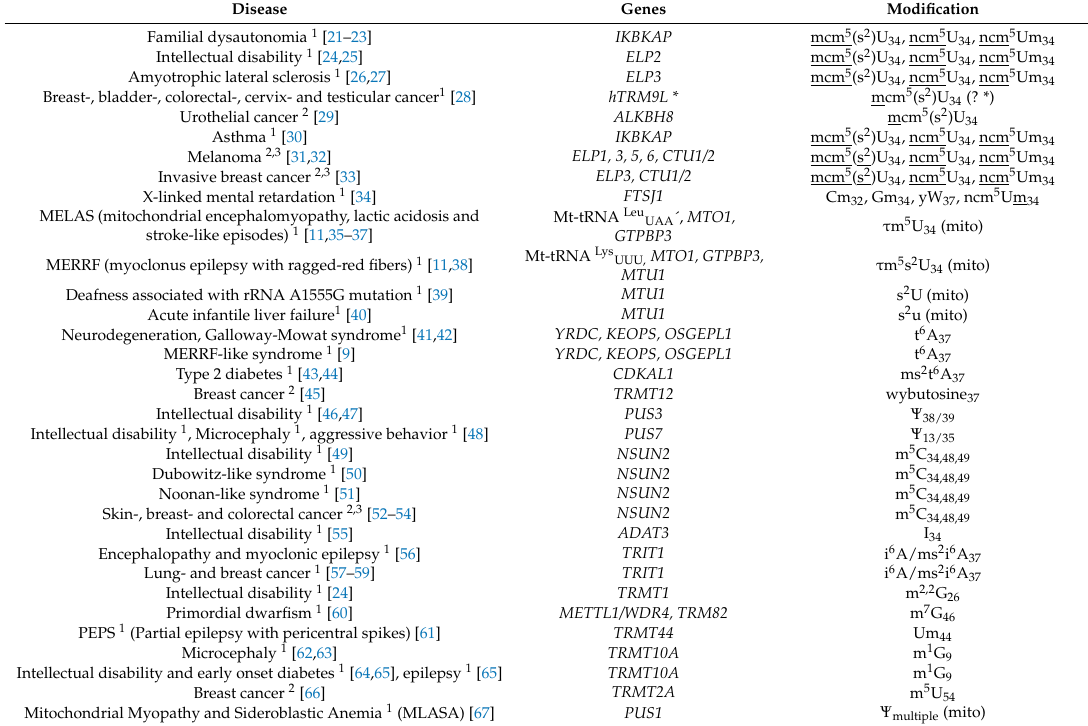
Table 1. Transfer RNA (tRNA) modification genes linked to human